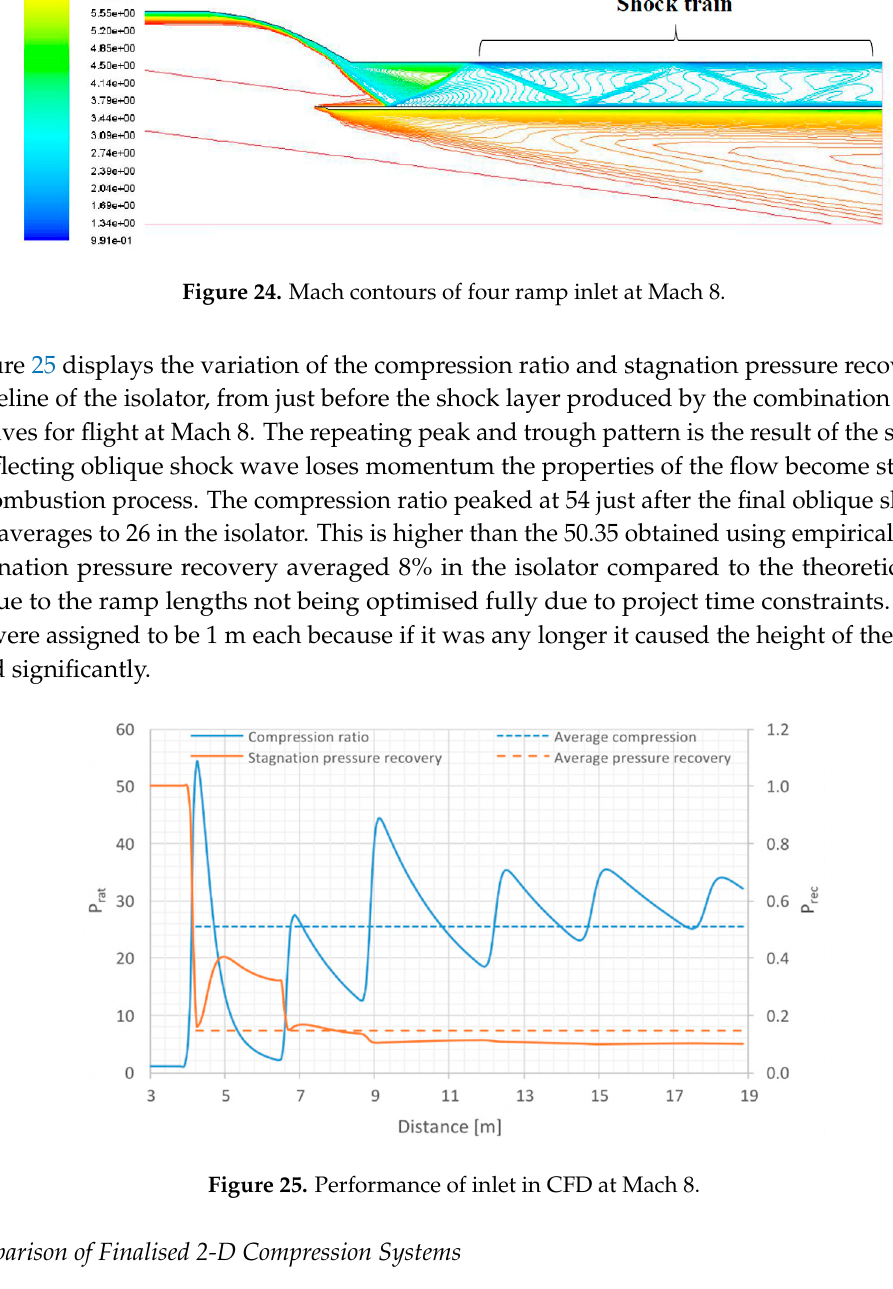
Figure 23. Mach contours of four ramp inlet at Mach 7.